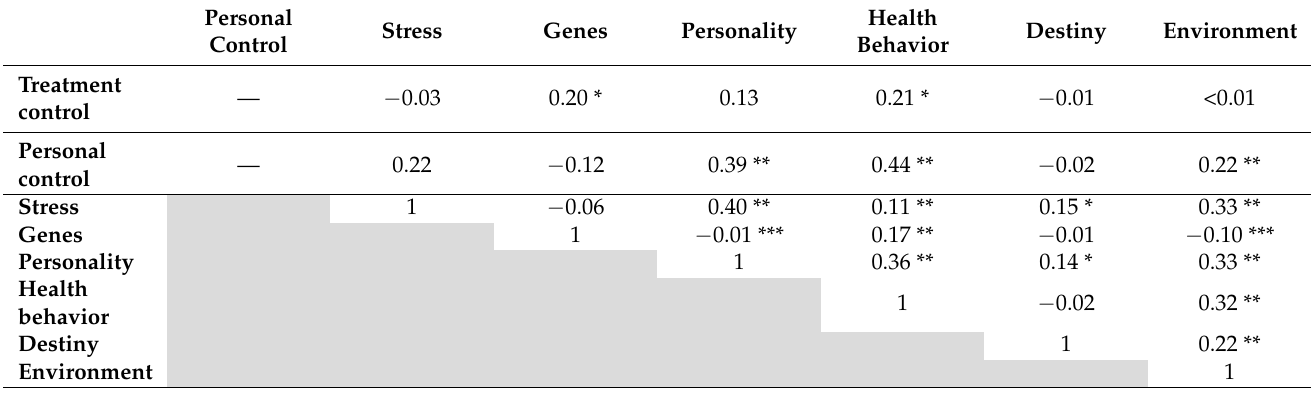
Table 2. Correlations between causal attributions and treatment/personal control ( N = 101).